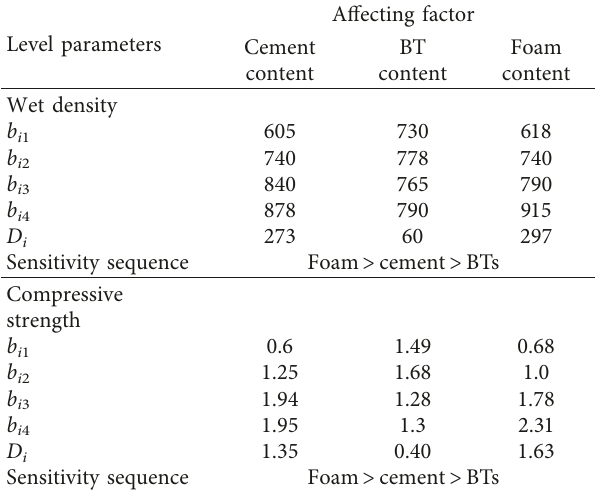
Table 5: Results of the range